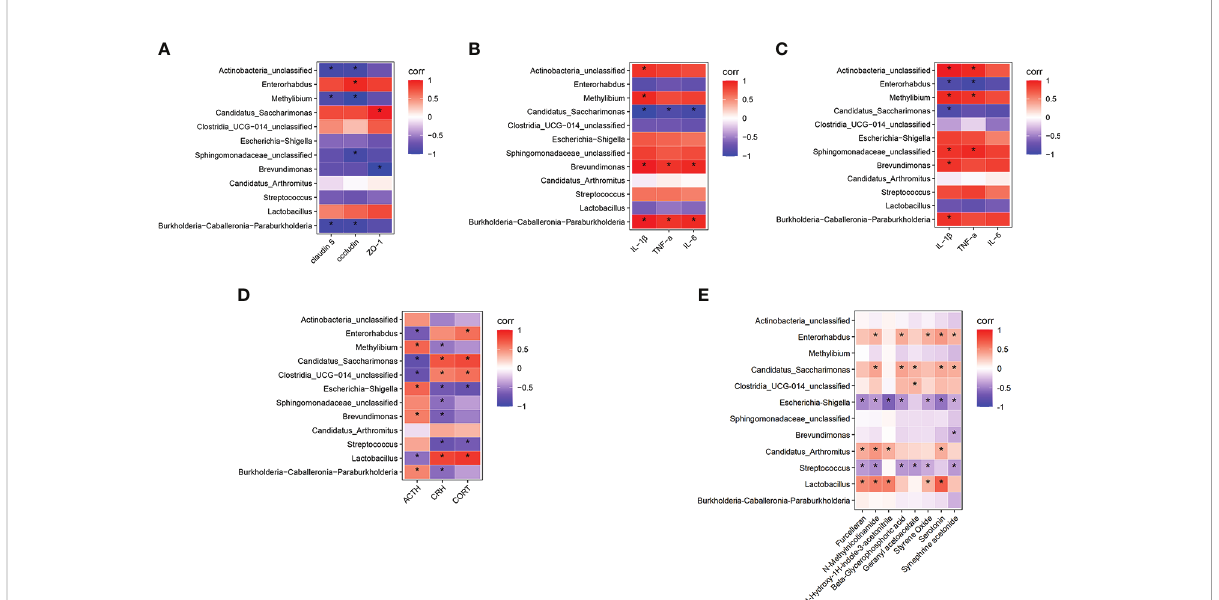
FIGURE 6 Correlation analysis of differential bacterial genera in model group and control group with gut barrier, gut in fl ammation, neuroin fl ammation, functional changes of HPA axis, and differential serum metabolites. (A) Correlation analysis between the differential bacterial genera and the gut tight junction protein. (B) Correlation analysis between the differential bacterial genera and the gut in fl ammation. (C) Correlation analysis between the differential bacterial genera and the neuroin fl ammation. (D) Correlation analysis between the differential bacterial genera and the HPA axis function changes. (E) Correlation analysis between the differential bacterial genera and the differential serum metabolites. The color of the grid represents the correlation analysis value of the Spearman correlation analysis. Red grids represent positive correlations and blue grids represent negative correlations. The color-coded scale represents the correlation analysis value of the heatmap, with darker red or blue indicating higher correlation values. * P < 0.05 for differential bacterial genera, gut barrier, gut in fl ammation, neuroin fl ammation, functional changes of HPA axis and differential serum